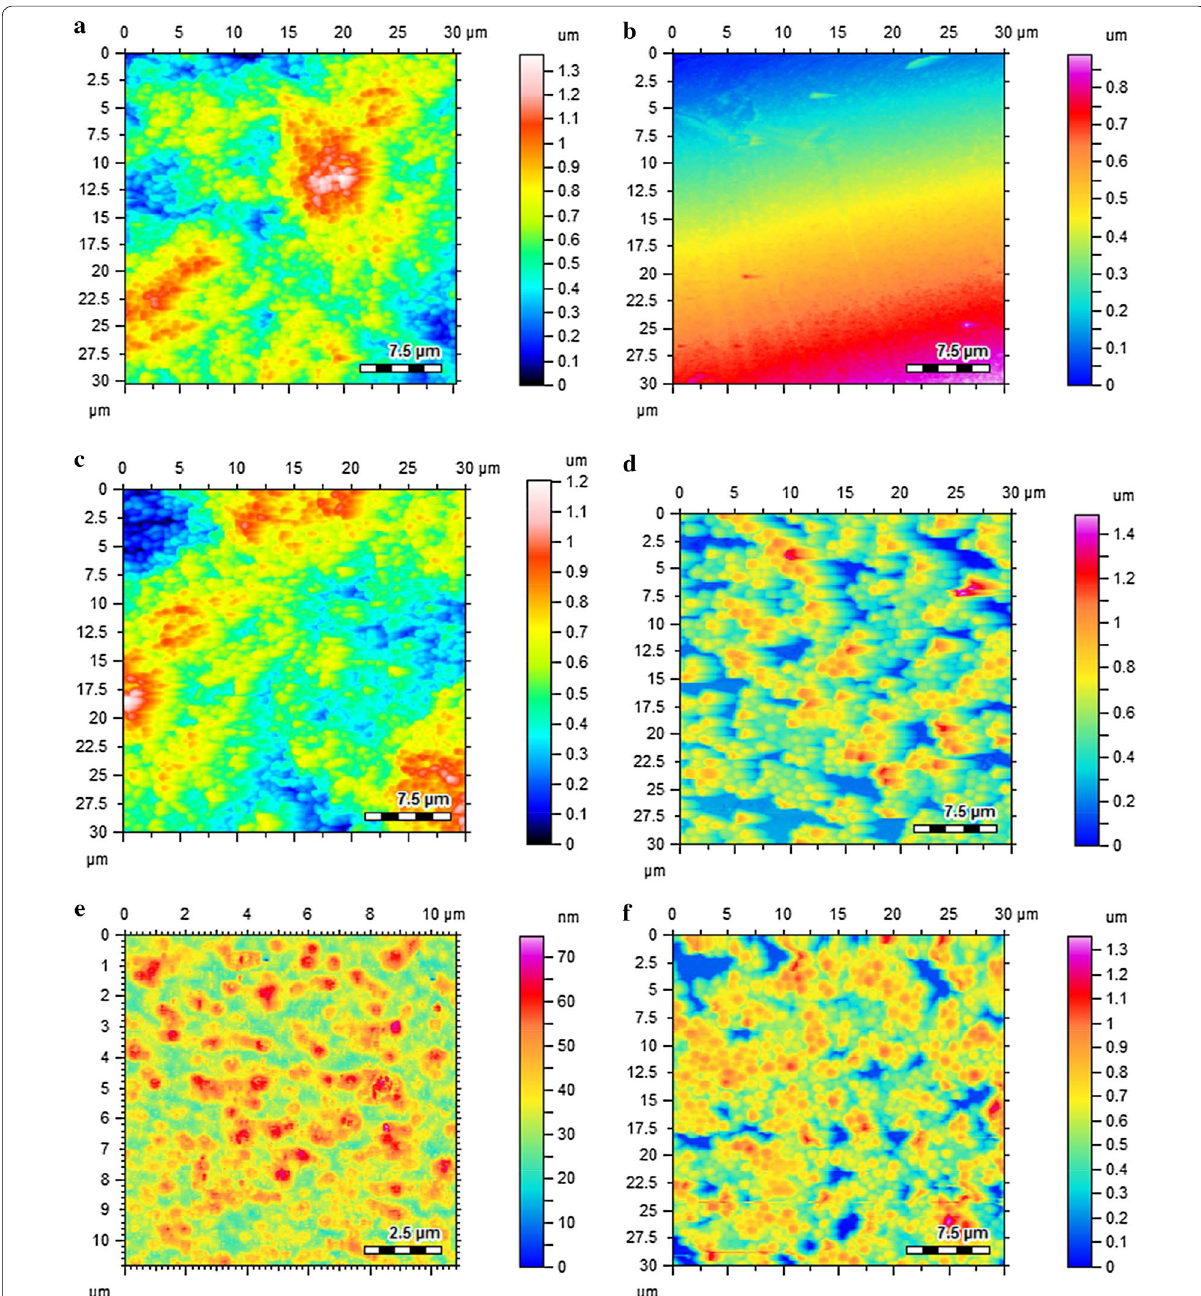
Fig. 6 AFM topographic images of S. aureus biofilms; a biofilm untreated; b Au-LPa small treated; c Au-LPa large treated; d gold nanomaterials large control treated; e gold nanomaterials small control treated; f LPa alone